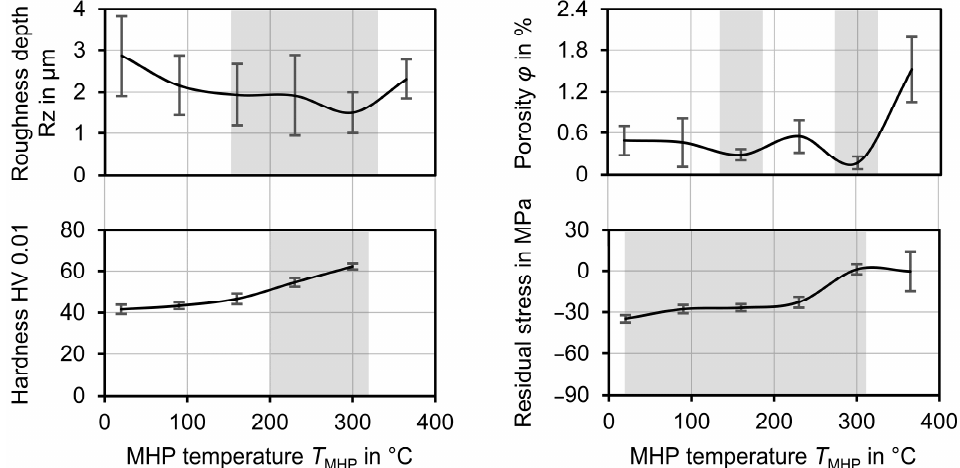
Figure 12. Summary of the resulting roughness depth, porosity, hardness and residual stress for ZnAl4 coatings peened with different process parameter settings at temperatures between T MHP = 20 °C and T MHP = 365 °C with suitable temperature areas highlighted. T MHP = 20 ◦ C and T MHP = 365 ◦ C with suitable temperature areas